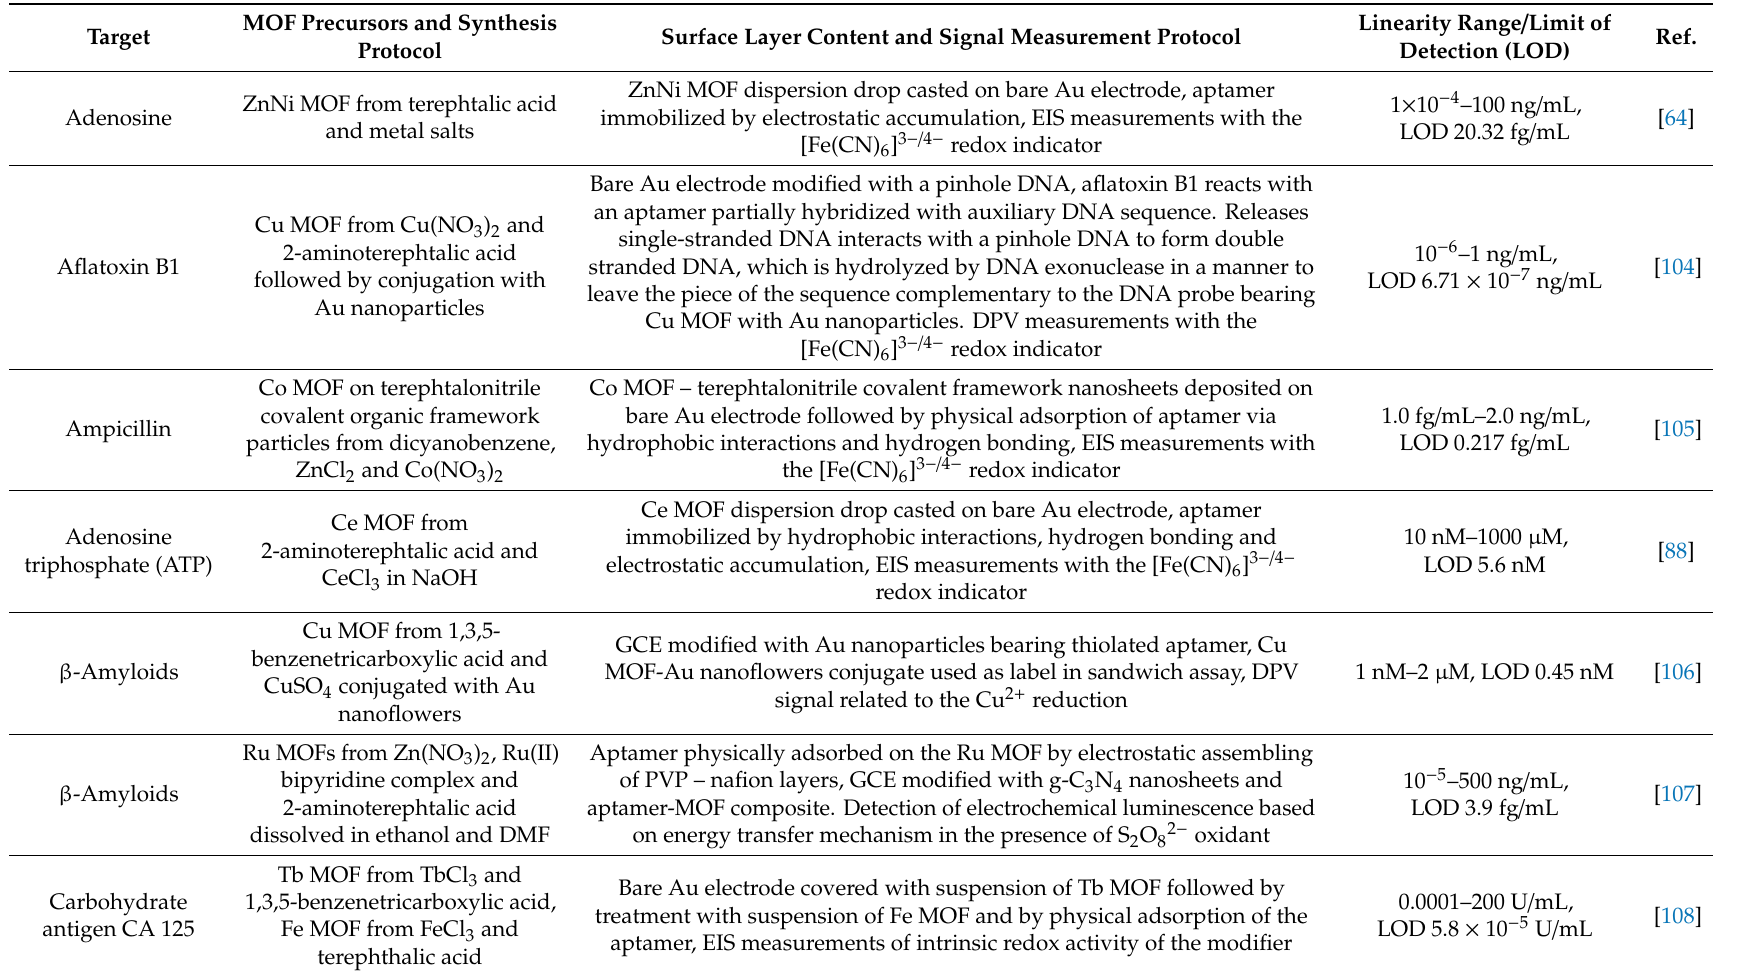
Table 1. The characteristics of electrochemical MOF-based aptasensors. LOD - limit of